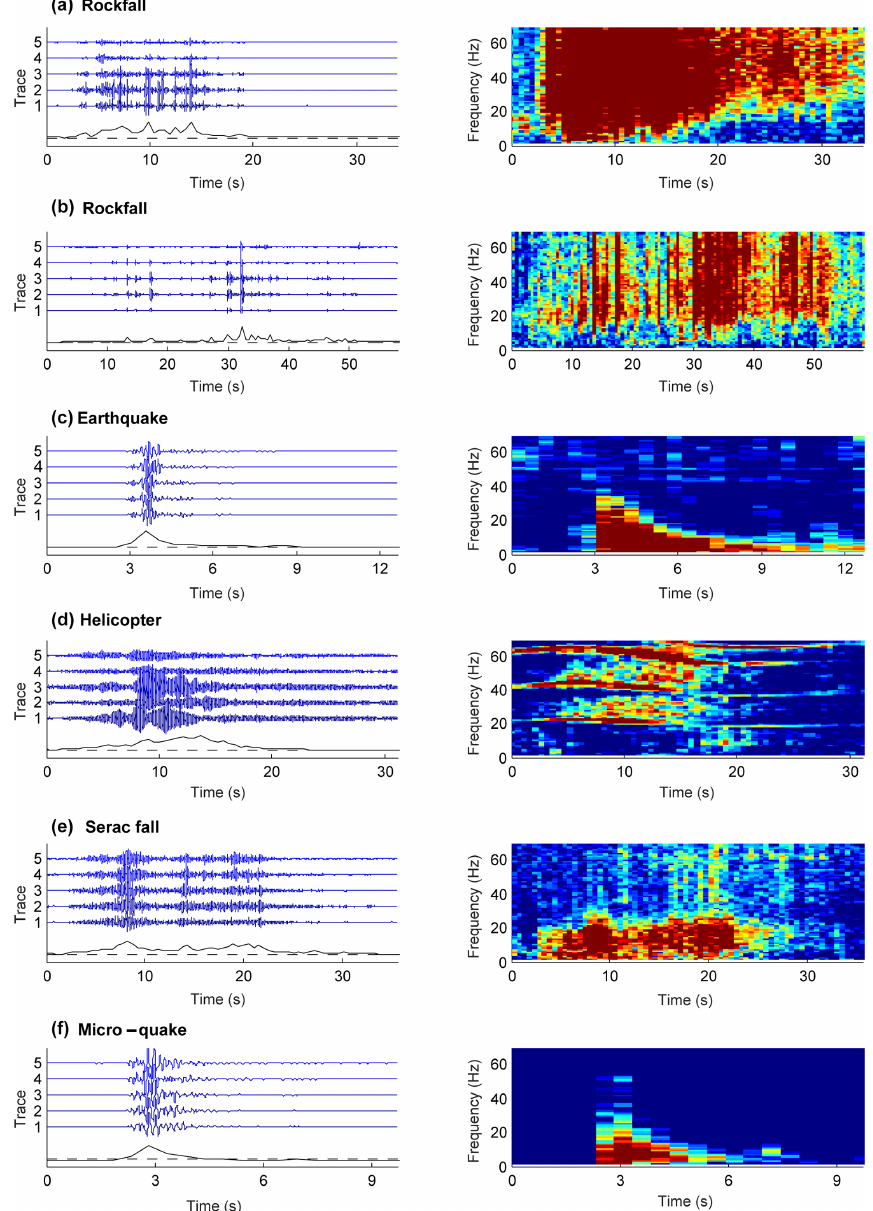
Figure 2. Example of typical signals recorded by the seismic network on 28 June 2019: two rockfalls in the Grand Couloir du Goûter (a, b) , a local earthquake (c) , a helicopter (d) , a serac fall from the north face of the Bionnassay (e) and a micro-quake (f) . On the left, the seismic waveforms at each sensor (1 to 5) are represented in blue and the seismic envelope is shown in black. The right panels present the spectrograms at low frequencies (0–75Hz) averaged over all the sensors. Red represents a higher energy than